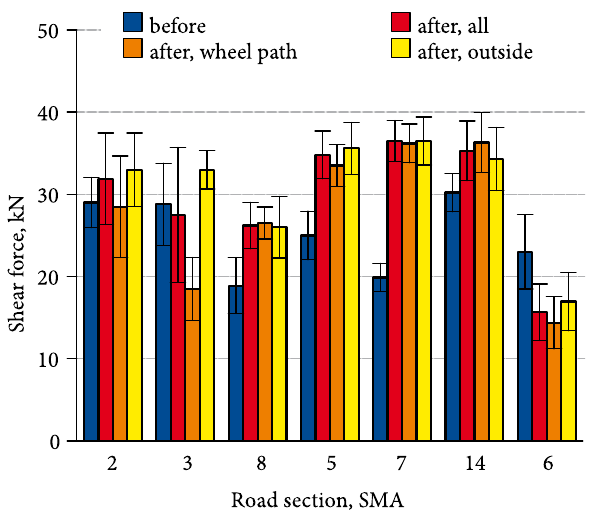
fig. 2. Comparison of shear forces at 20 °C directly after construction and after several years of traffic for all road sections with SMA surface course